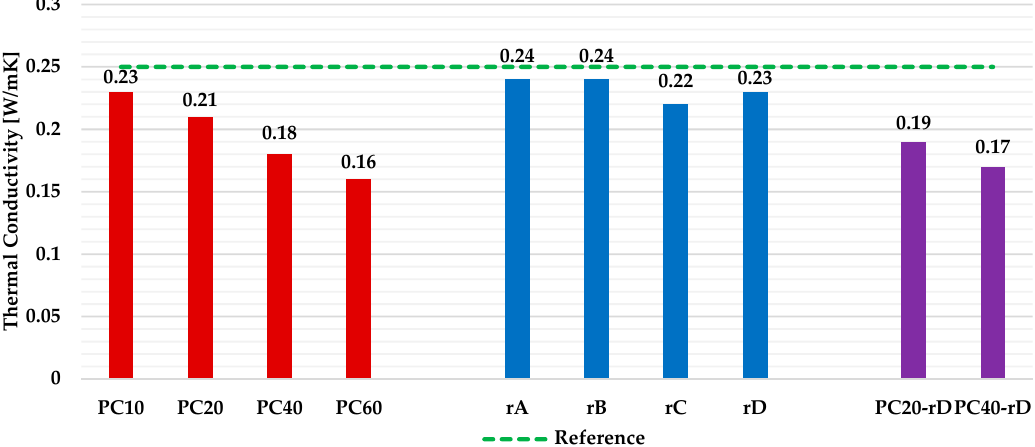
Figure 10. Thermal conductivity of the various gypsum plates under study.